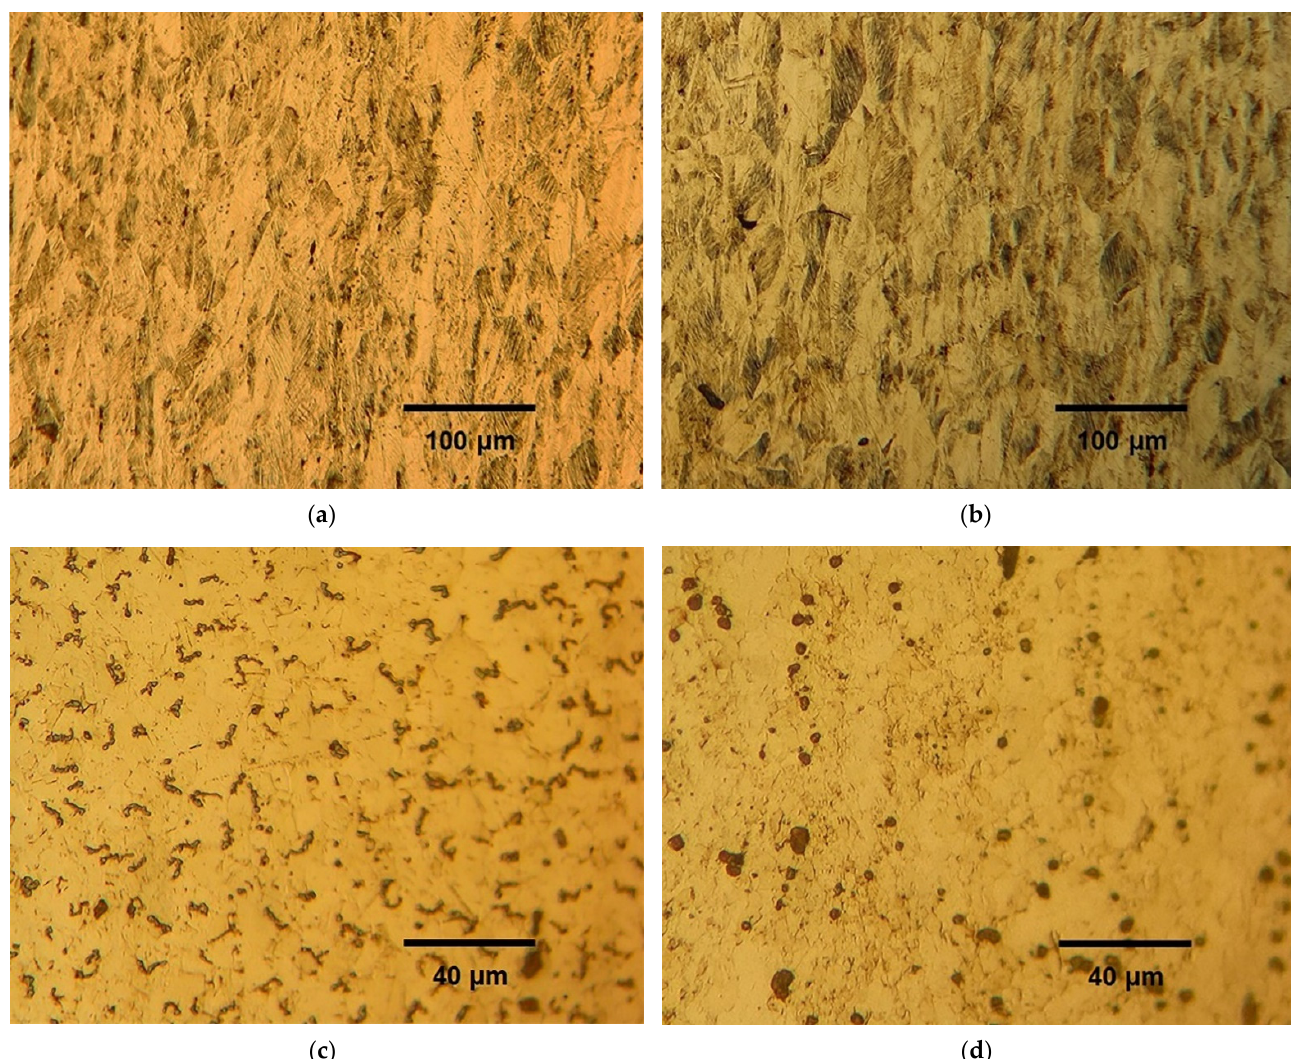
Figure 6. Microstructures of the Fe-0.5 C-21.5 Mn TWIP steel cold rolled to 31% ( a , b ) and 52% ( c , d ), after annealing at 600 °C ( left ) and 700 °C ( right ).